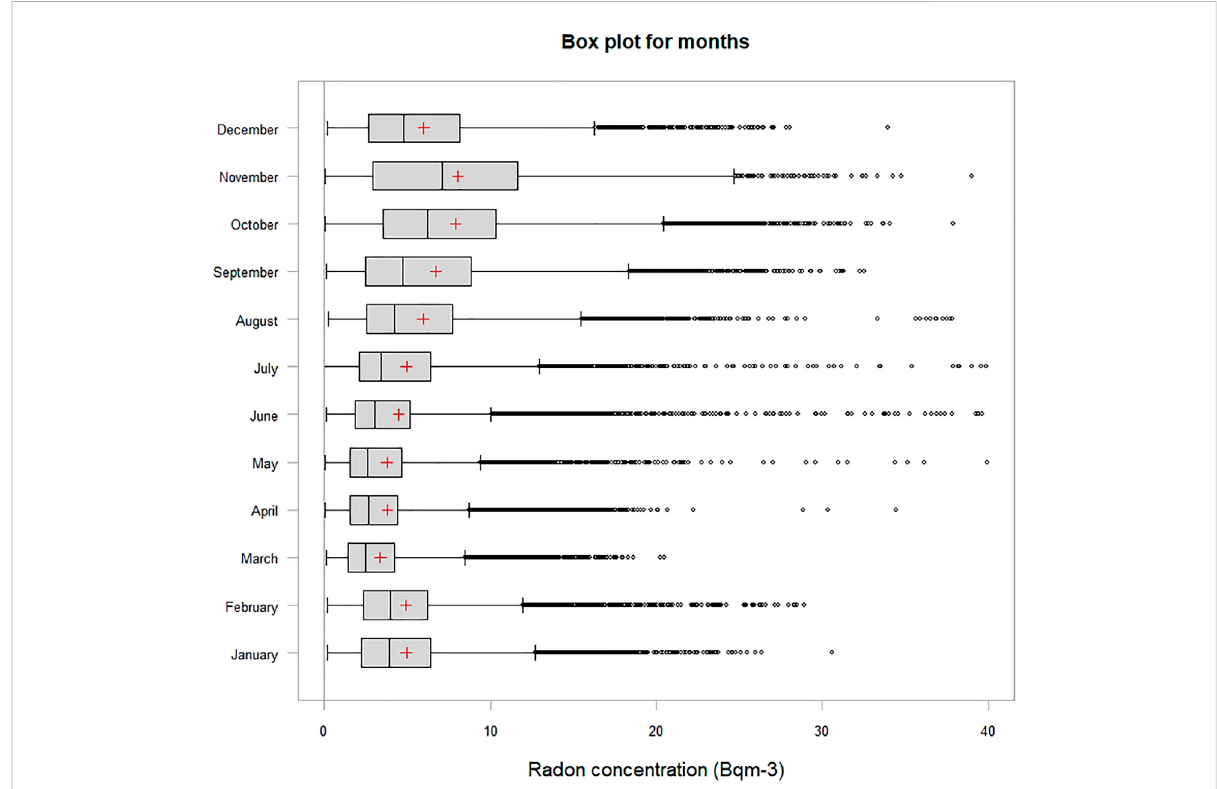
FIGURE 4 Monthly averaged box-and-whisker plot of all radon concentration measurements. The left and right box borders represent 25 th and 75 th percentiles, whiskers extends interquartile range by factor 1.5, vertical bar represents the median, red cross, the mean value and black circles, the